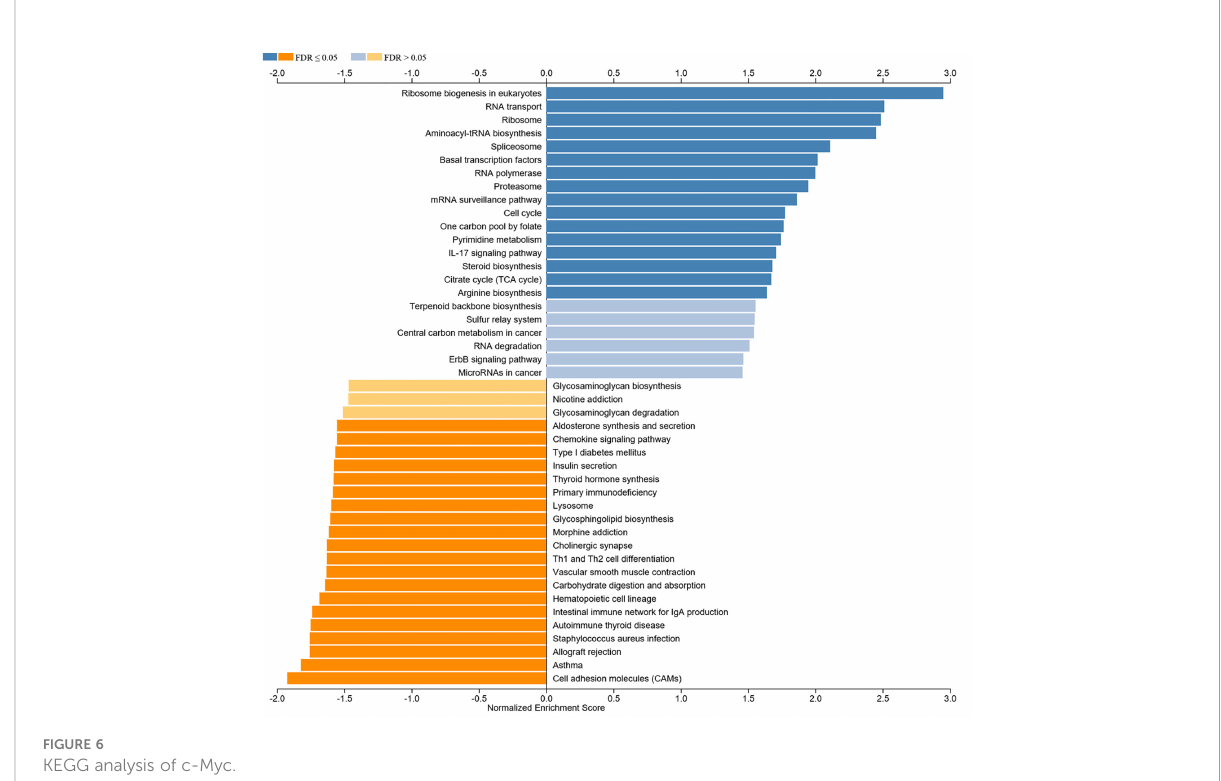
FIGURE 6 KEGG analysis of